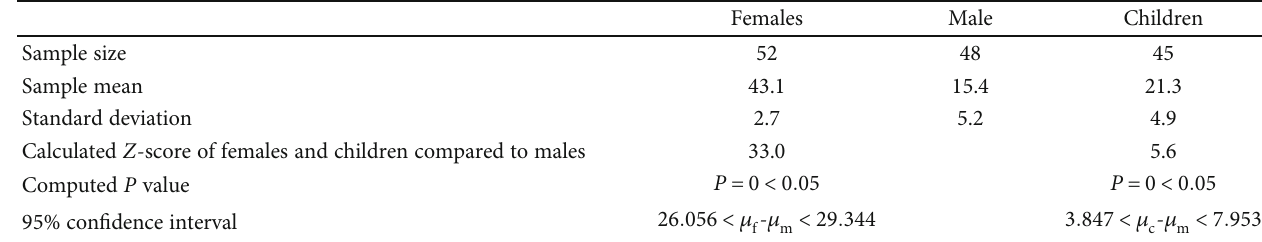
Table 6: Results for statistical signi fi cance of time savings among females, children, and